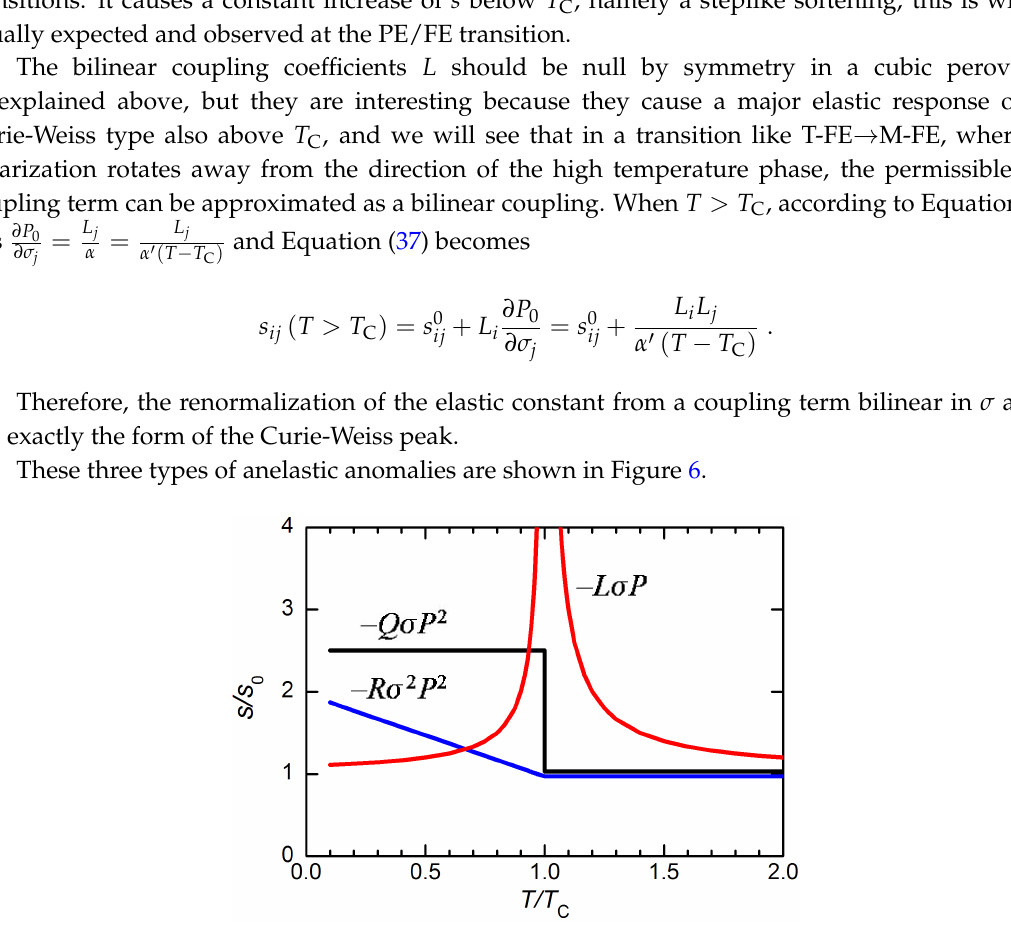
Figure 6. Anomalies in the elastic compliance from the three types of stress-polarization coupling discussed in the